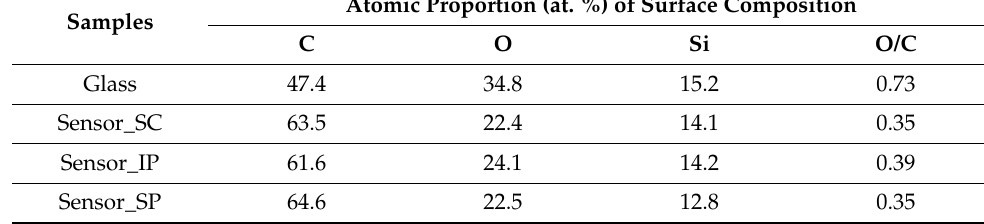
Table 3. Surface elemental composition of the substrate (glass) and optical sensor layers prepared with different techniques: spin coating (Sensor_SC), inkjet printing (Sensor_IP), and spray coating (Sensor_SP).